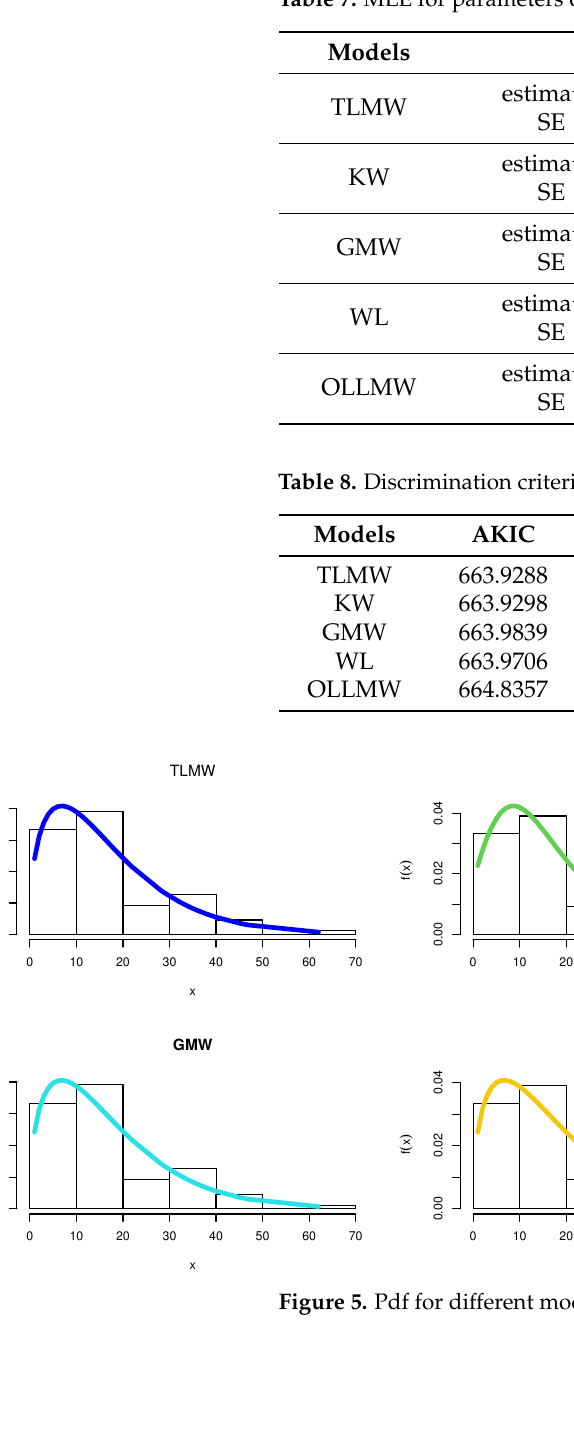
Table 7. MLE for parameters of TLMW and comparative models for COVID-19 data.